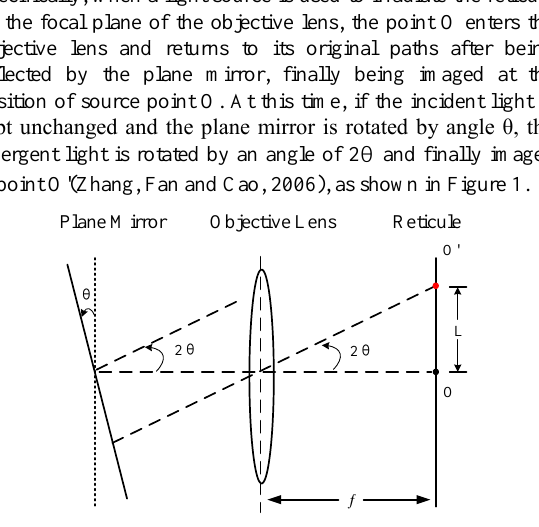
Figure 1. Optical auto-collimation schematic Denote the distance between the emission point and the imaged point by L, with a focal length